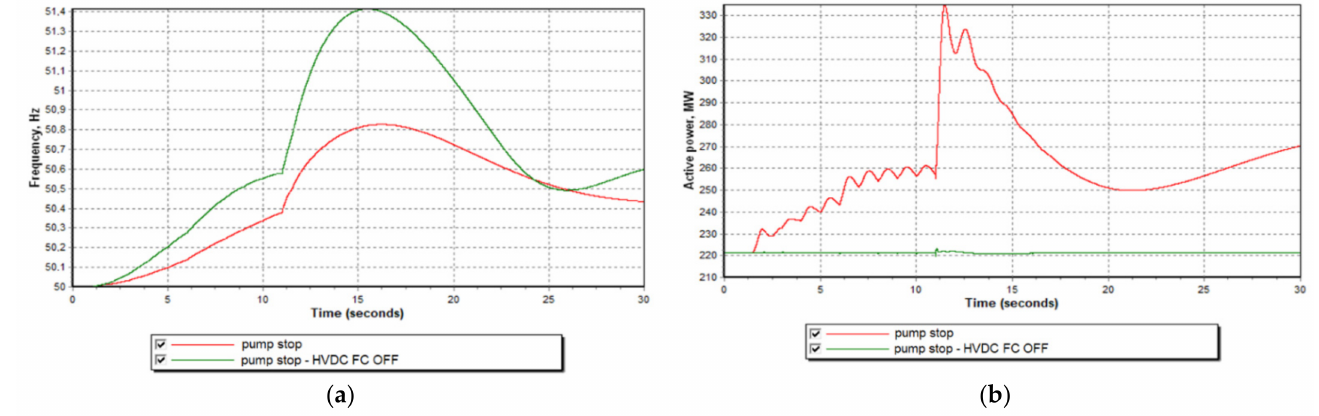
Figure 26. ( a ) Frequency change in the isolated power system caused by disconnection of the unit operating in pump mode. ( b ) Response of the HVDC BtB converter to a disconnection of the unit operating in pump mode.